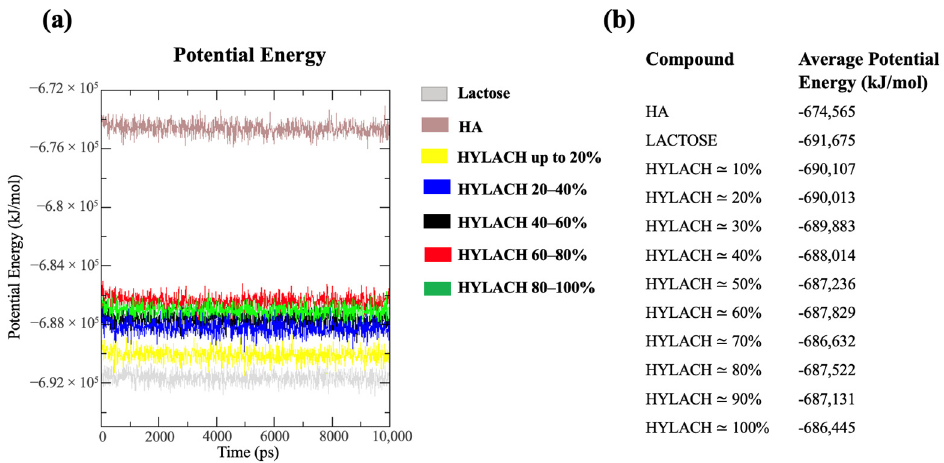
Figure 2. Results of potential energy. ( a ) The trend in simulation time (10,000 ps) of the potential energy of HYLACH, HA, and lactose and ( b ) Values of potential energy for lactose, HA, and percent- ages of HYLACH lactosylation. The lowest potential energy is associated with lactose and HYLACH of up to 30% of lactosylation. The system containing HA and Gal-3 is the least energetically favored as it has the highest potential energy value. Table 2. Average binding free energies of the